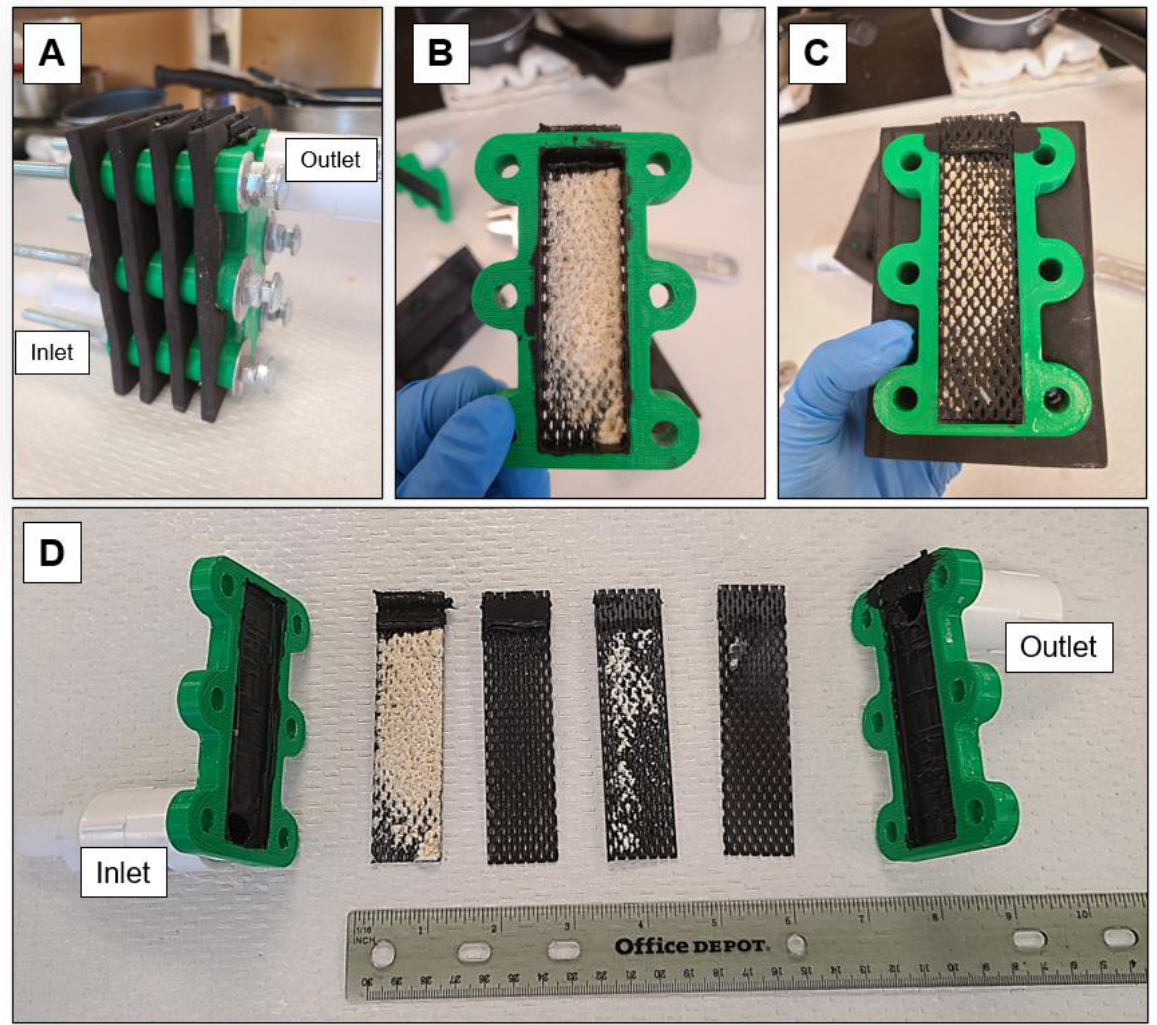
Figure 11. Photographs of pilot-scale BDD reactor after treatment: ( A ) before disassembly. ( B ) first BDD electrode (front side facing incoming solution) and ( C ) back side of first electrode. ( D ) Front side of all 4 BDD electrodes.